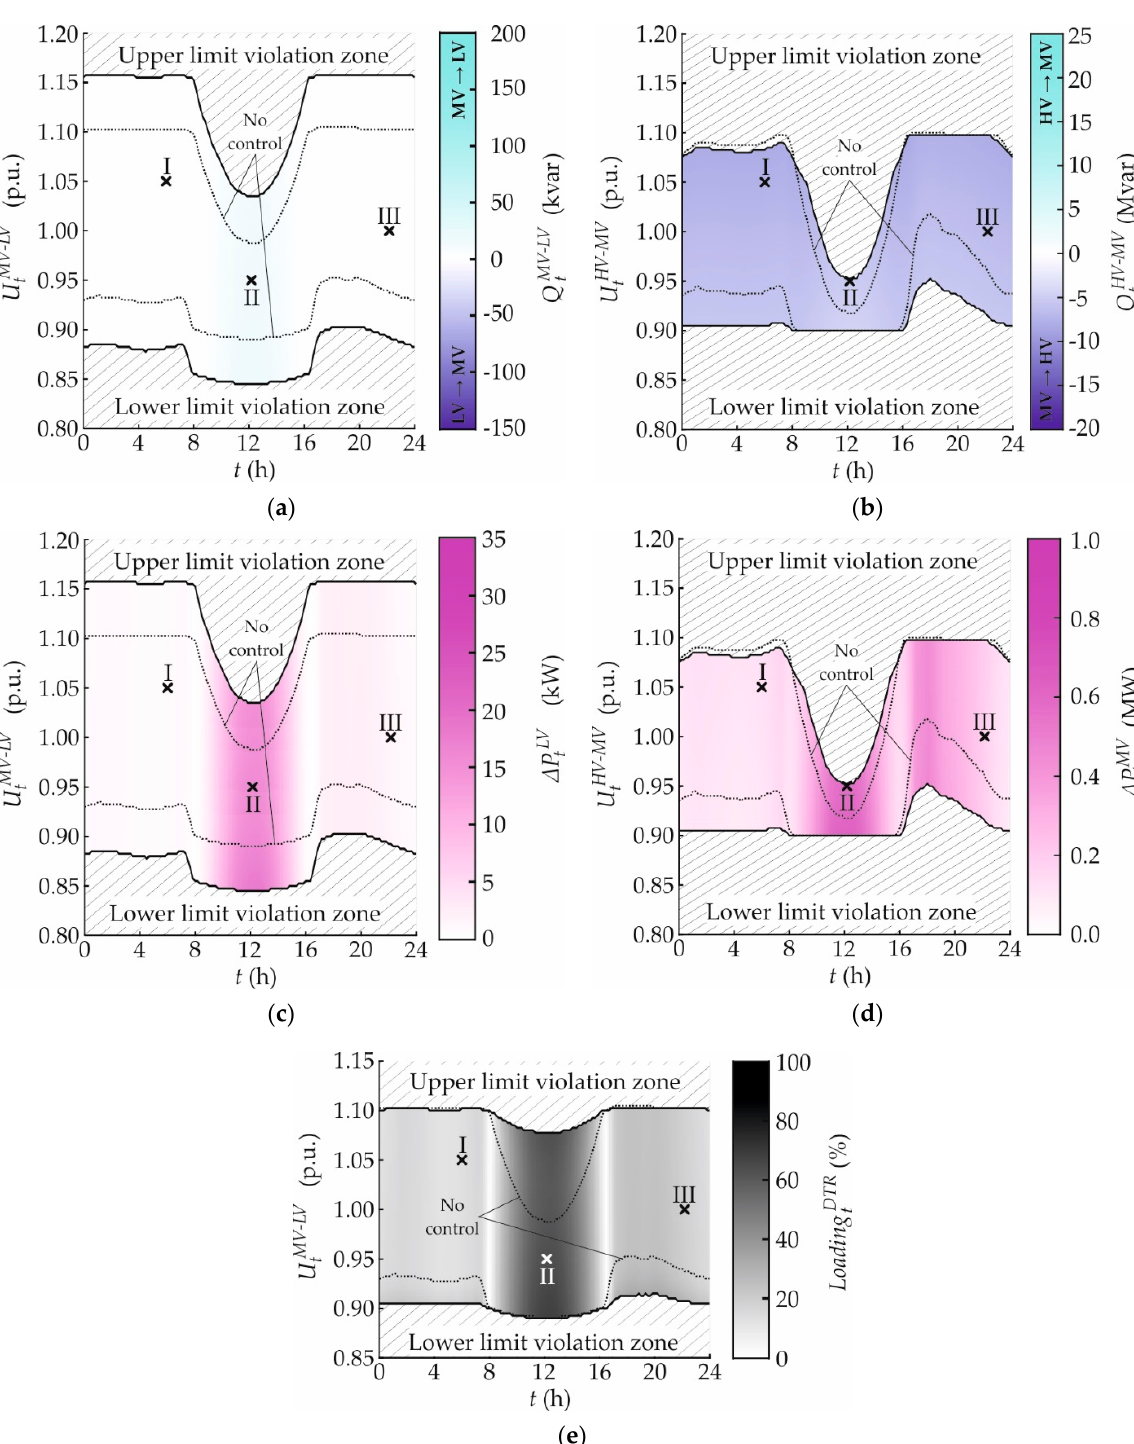
Figure 20. Daily behavior of the test link chain for various boundary voltages, the X ( U ) local control, and CP_ Q -Autarky: ( a ) reactive power exchange over the MV − LV boundary (rural LV_Link-Grid); ( b ) reactive power exchange over the HV − MV boundary; ( c ) active power loss within the rural LV_Link-Grid; ( d ) active power loss within the MV_Link-Grid; ( e ) DTR loading (rural LV_Link-Grid).